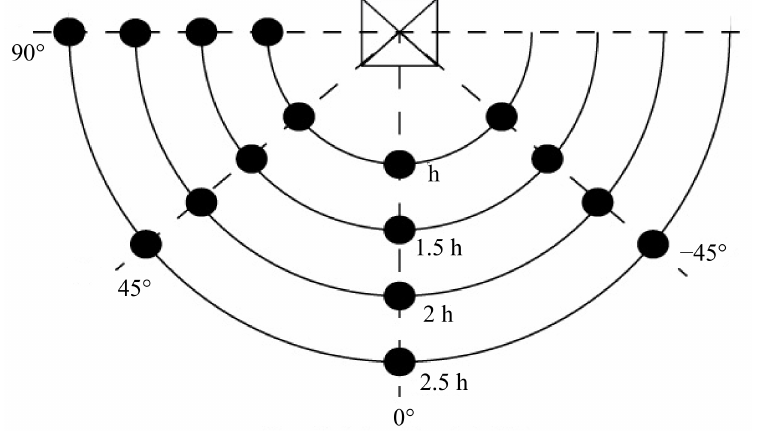
Figure 4. Observation points in the relationship between the height and observation angle intervals.